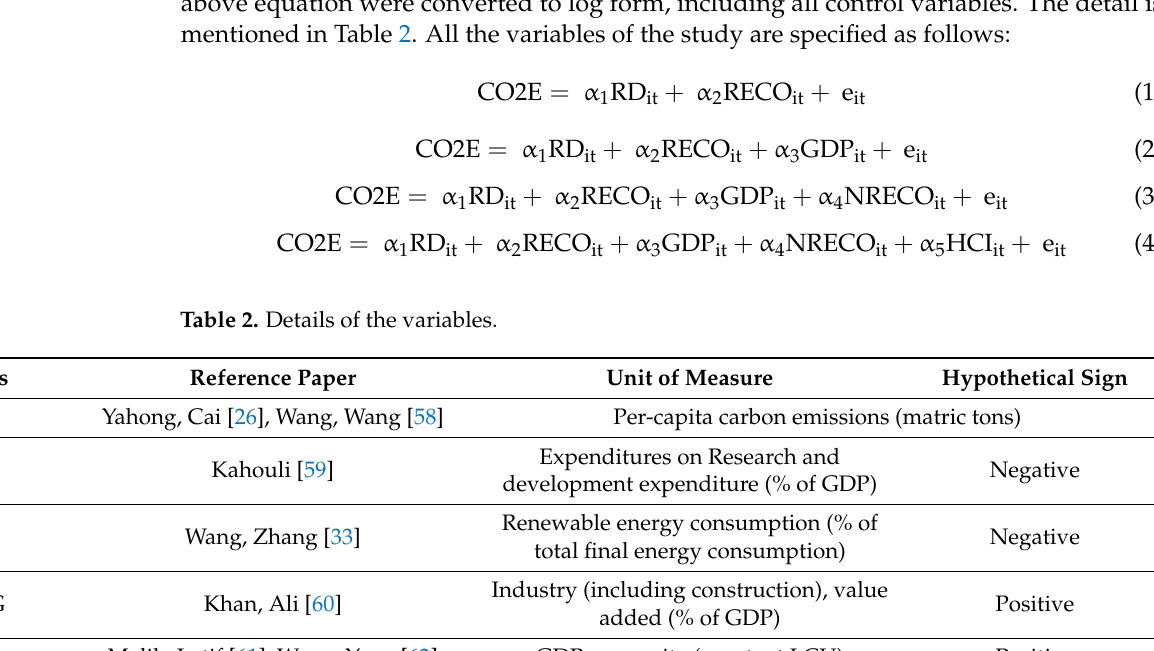
Table 2. Details of the variables.